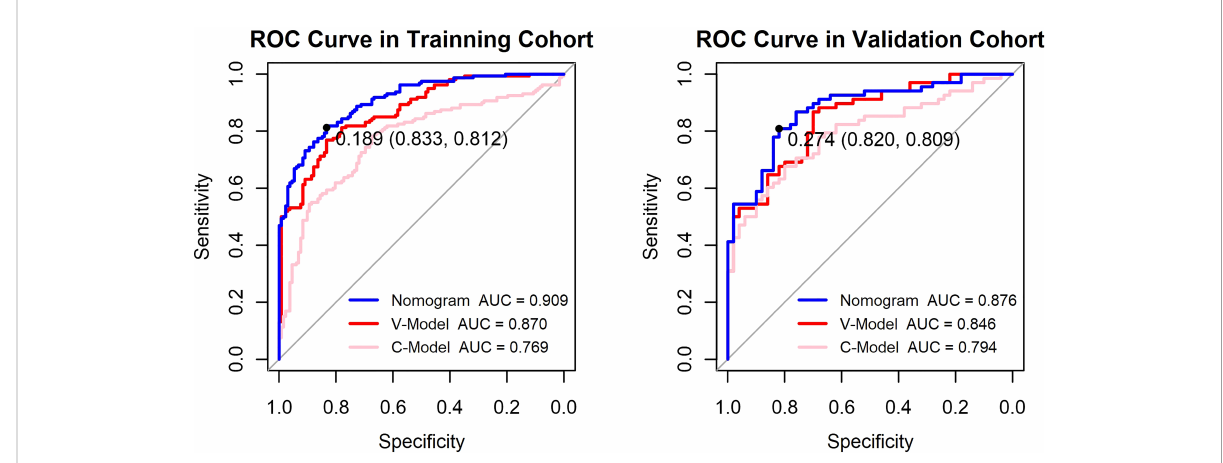
FIGURE 4 Receiver operating characteristic (ROC) curves of the constructed models. The y-axis means the true-positive rate of the risk prediction. The x- axis means the false-positive rate of the risk prediction. The blue line represents the performance of the nomogram. The cutoff value and area under the receiver operating characteristic curve (AUC) are presented in the picture as